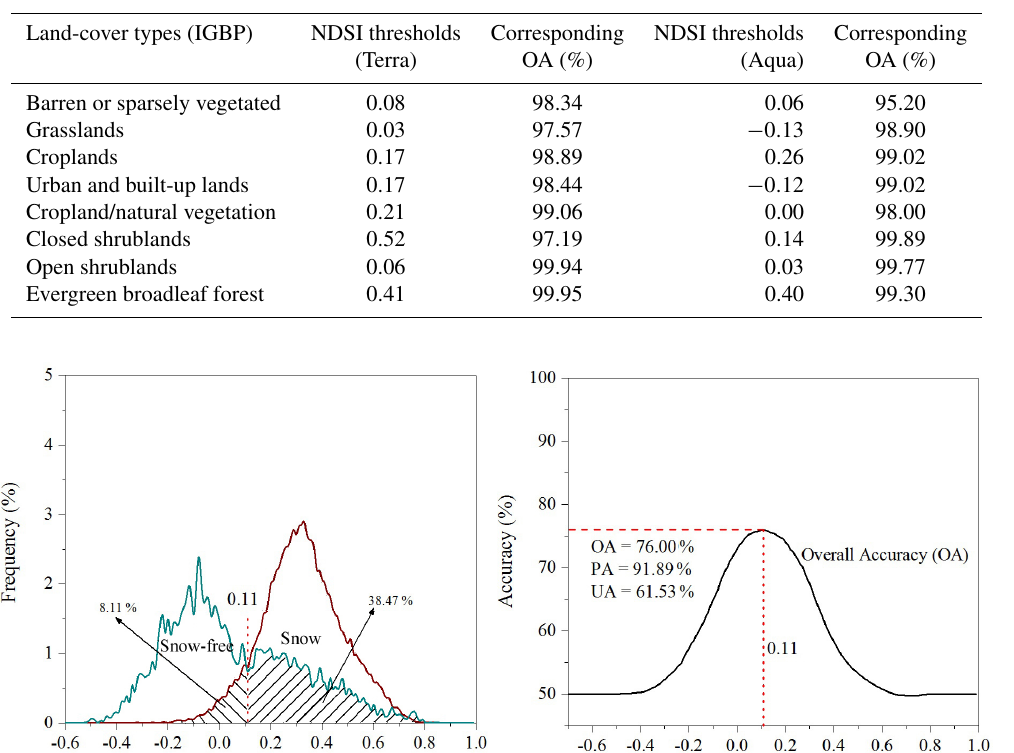
Table 1. Optimal NDSI thresholds over eight non-forest land-cover types.